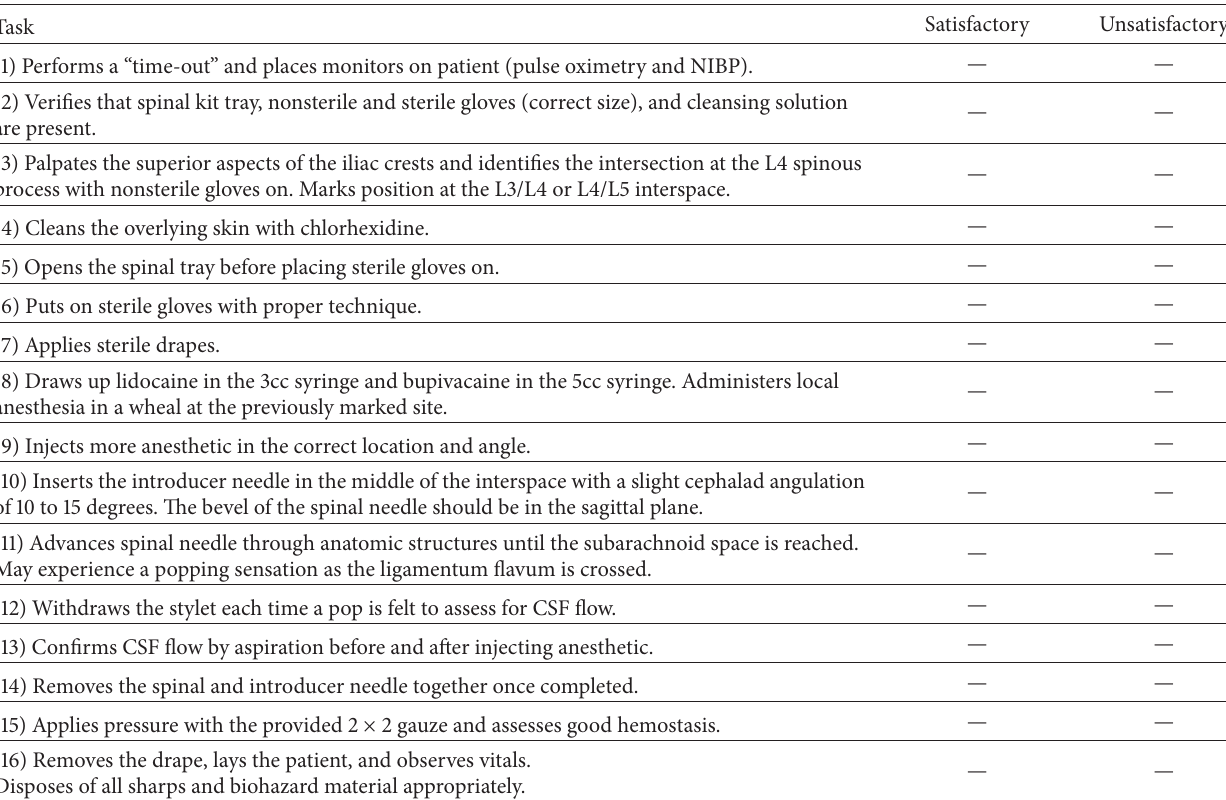
Table 1: Procedural checklist for subarachnoid